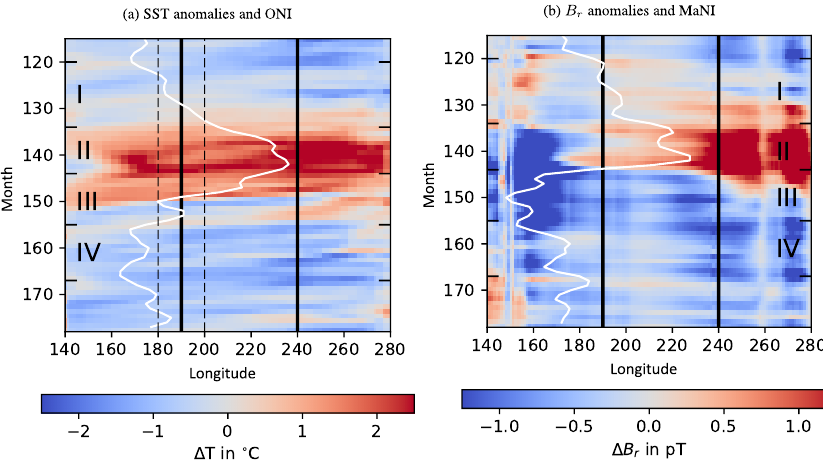
Figure 2. Hovmöller plots of sea surface temperature anomalies (a) and B r anomalies (b) averaged from 5 ◦ S to 5 ◦ N. The time interval shows the strongest ENSO cycle cf. Fig. 1. Vertical black lines enclose the Niño 3.4 region used to calculate ONI and MaNI. The solid white lines represent the indices derived from the individual anomalies centred on 170 ◦ E (20 ◦ of longitude corresponds to 1 ◦ C a and 0.4pT b ). The dashed lines represent the ONI thresholds for El Niño/La Niña of ± 5 ◦ C (a) .